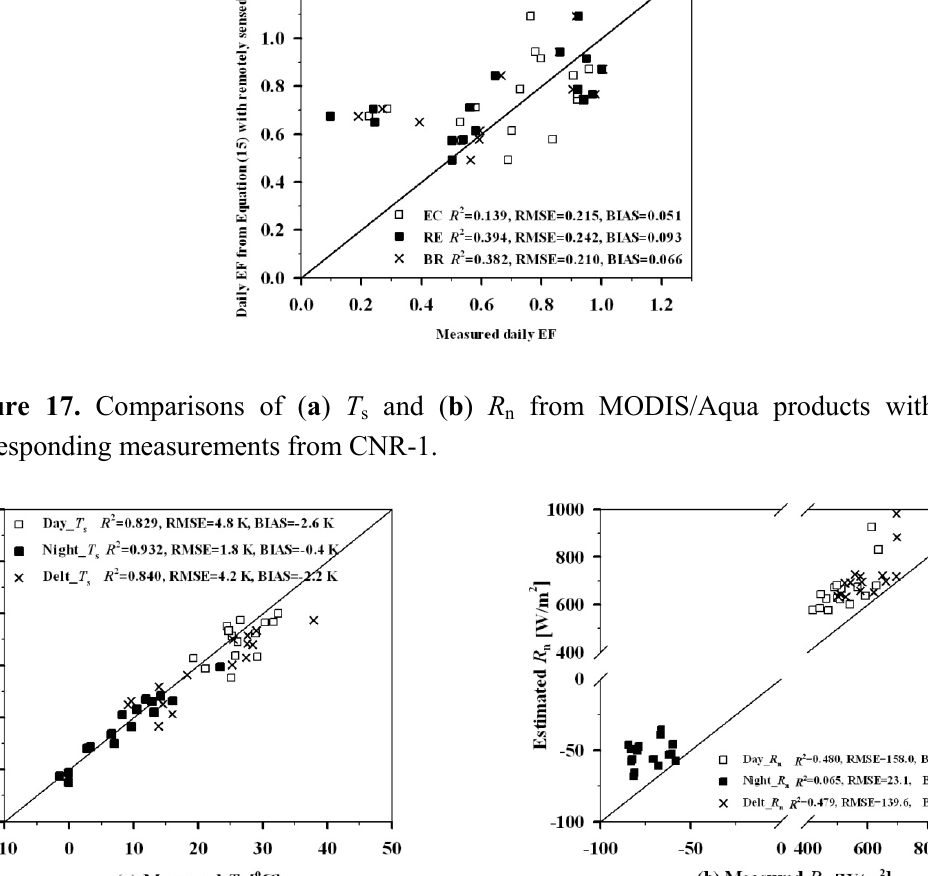
Figure 16. Comparisons of daily EF estimates from MODIS data with in situ measurements.